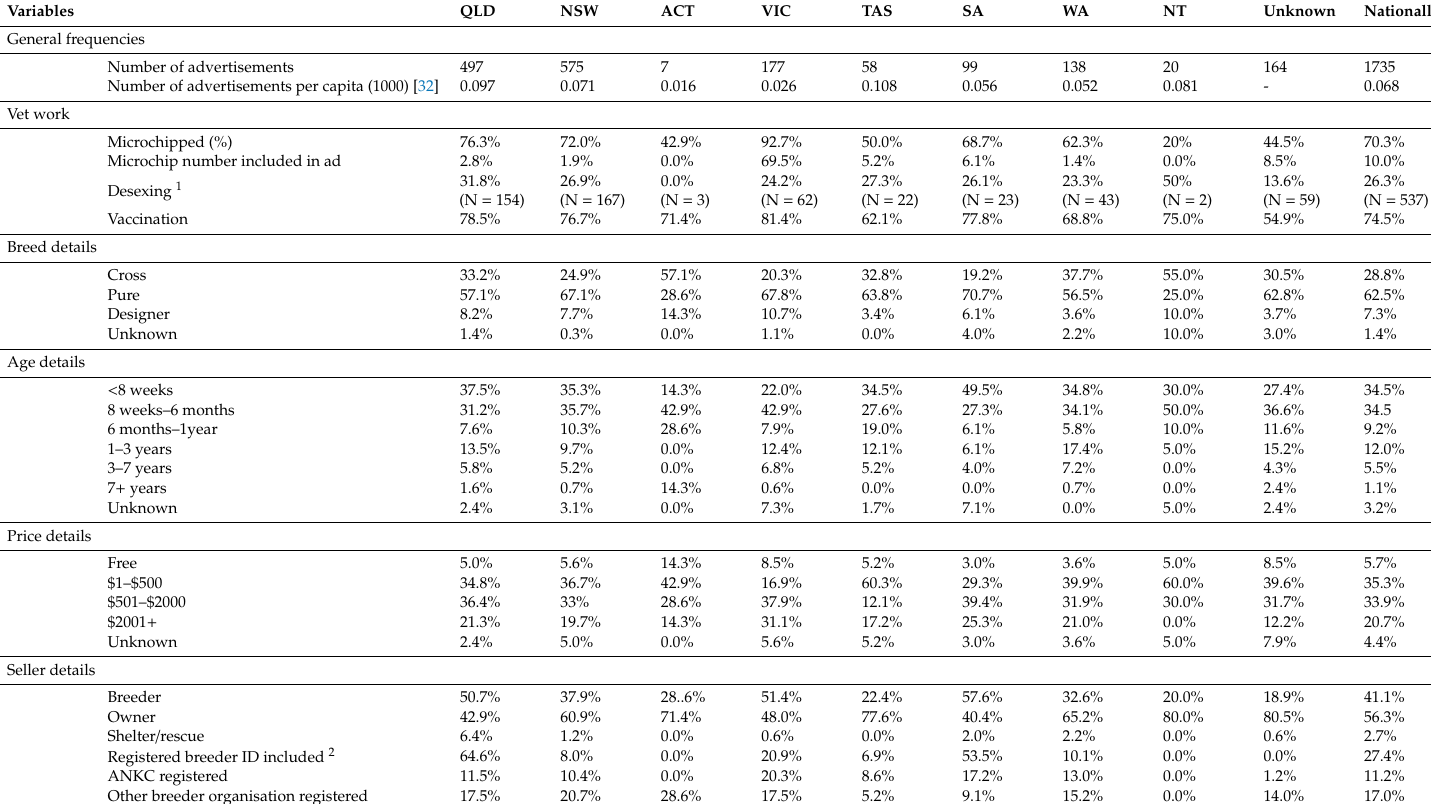
Table 2. Frequency per state of data acquired from two individual webscrapes from Gumtree dog and puppy advertisements (25 March and 8 April 2019) in Australia. Total of 1735 unique advertisements. For all rows, N equals ‘number of advertisements’ row, unless otherwise stated.